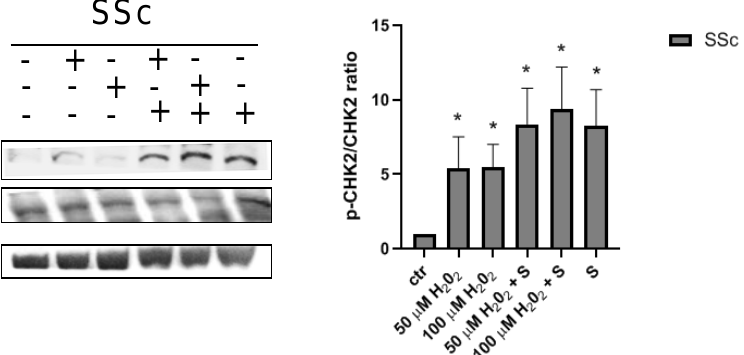
Figure 2. Analysis of DNA repair ability in healthy control (H) and SSc fibroblasts exposed to a pro-oxidant environment. ( A ) Representative immunofluorescence analysis of RAD51 in H and SSc fibroblasts treated with 50 and 100 µM H 2 O 2 for 1h in the presence or in absence of sildenafil 1 µM. The diagram represents the number of RAD51 foci per cell in healthy (black columns) and SSc (grey columns) fibroblasts. ( B ) Western blot analysis for a serine/threonine kinase (CHK2) phosphorylation in SSc fibroblasts. Diagram depicted a densitometric analysis expressed as the ratio p-CHK2/total CHK2. * p < 0.05, ** p < 0.01 vs. ctr, # p < 0.05, ## p < 0.01 healthy vs. SSc, §§ p < 0.01 H 2 O 2 vs. H 2 O 2 + S. Data represent mean ± SE. Results are derived from three separate experiments using different cell preparations. S, sildenafil.